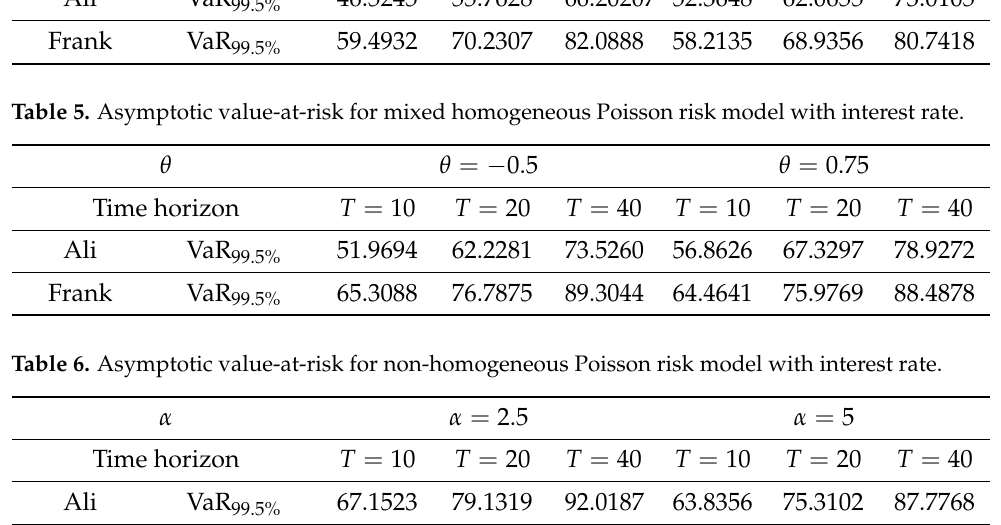
Table 4. Asymptotic value-at-risk for homogeneous Poisson risk model with interest rate. θ θ = − 0.5 θ = 0.75 Time horizon